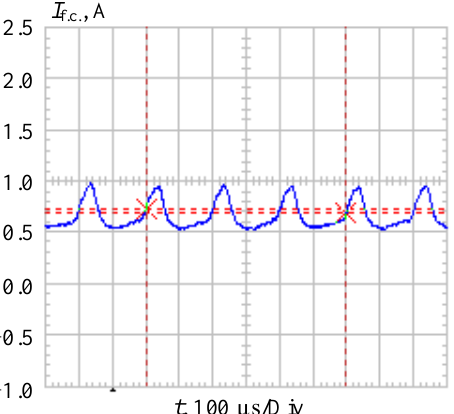
Fig. 13. Current of the fuel cell with rms 0.65 A in the case when load is partially powered by the fuel cell with a load filter.